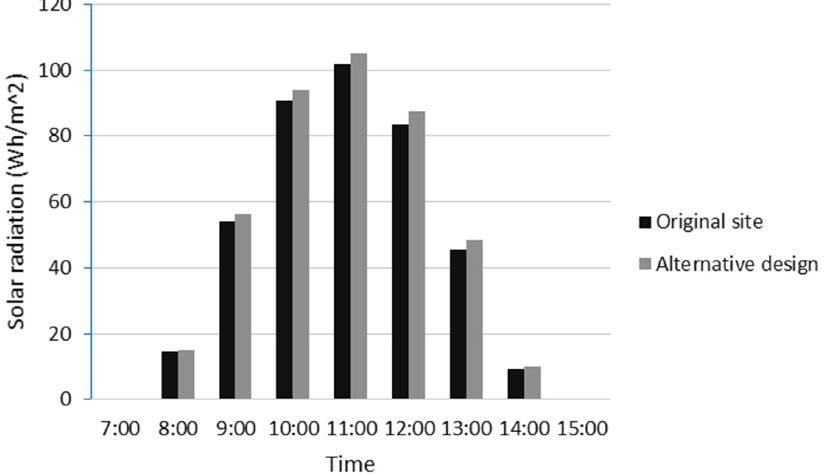
Figure 9. Average hourly solar radiation of case study location on the winter